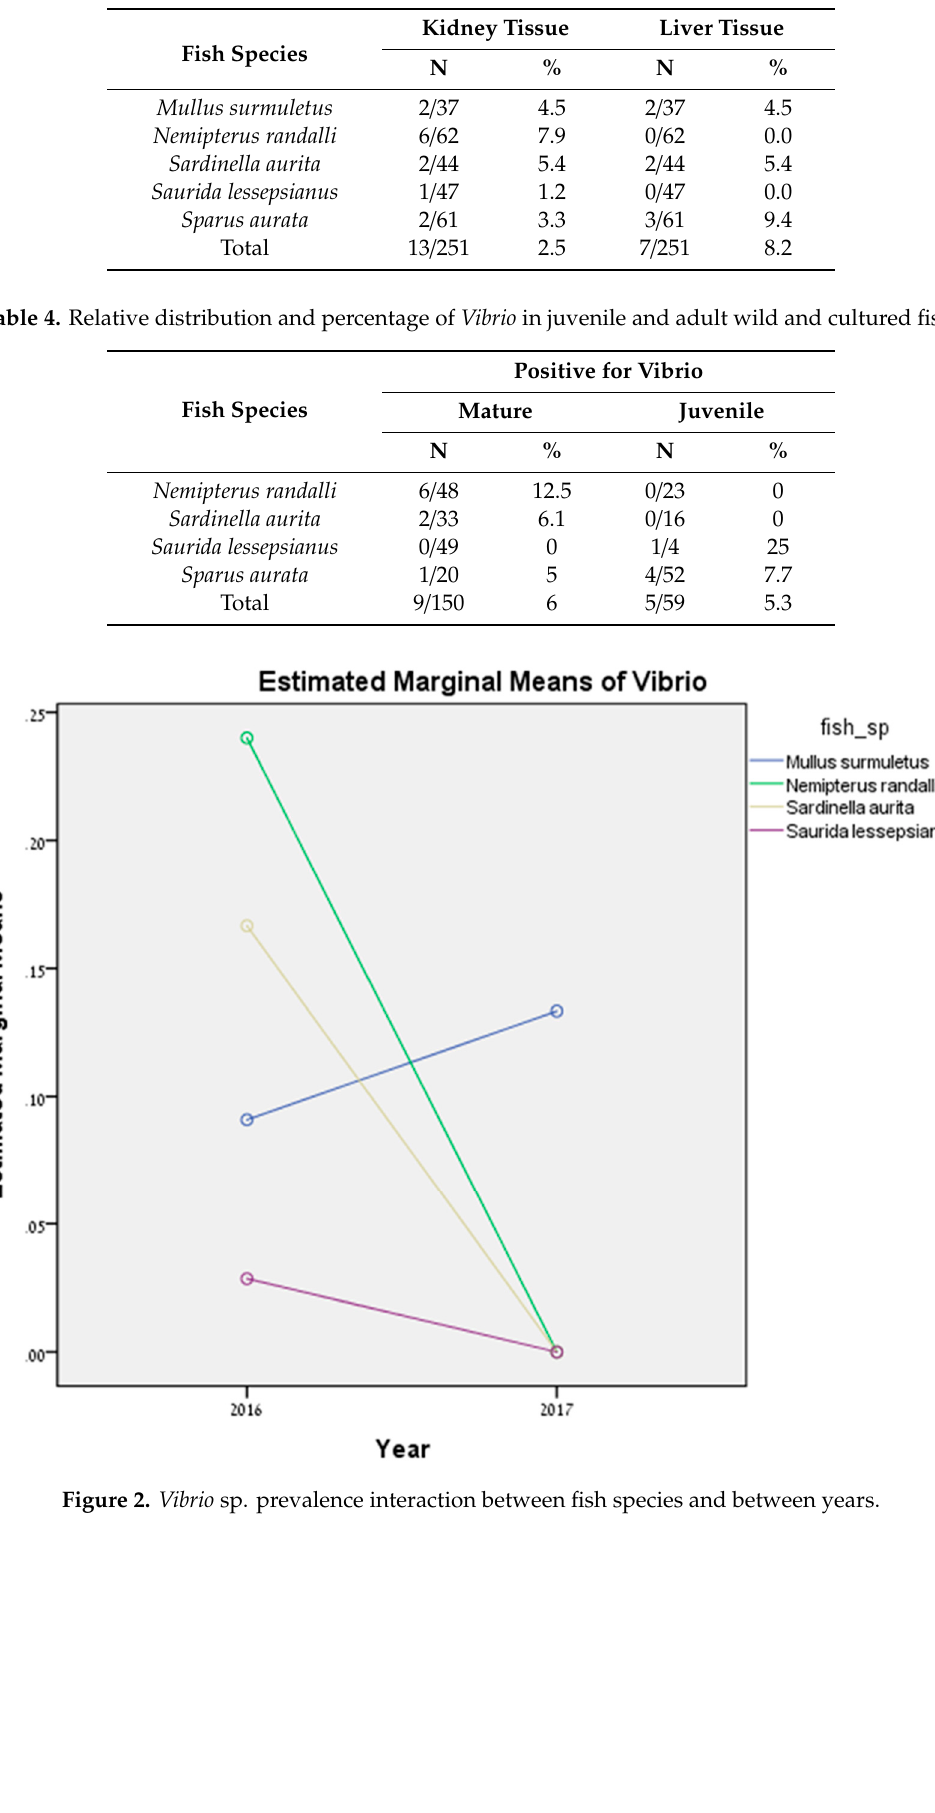
Table 3. Relative distribution and percentage of Vibrio in kidney and liver tissues from wild and cultured fish. Only specimens tested for both tissues were included in the statistical analyses.